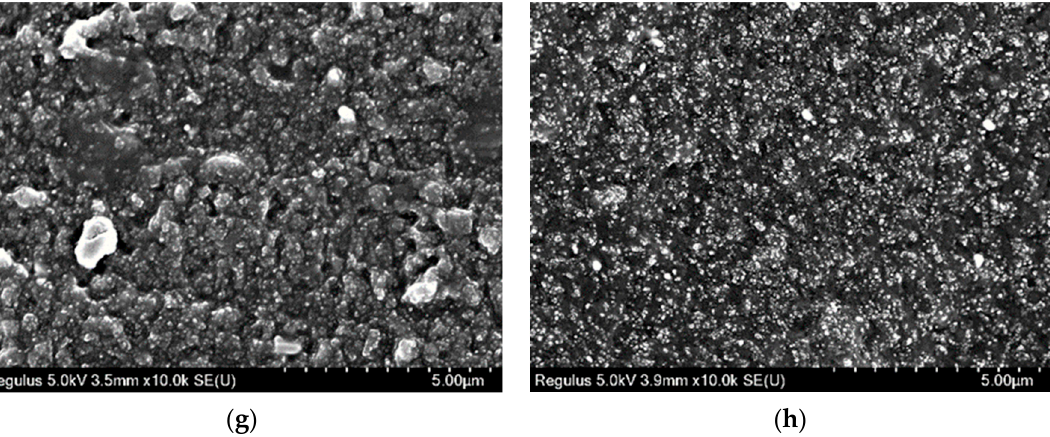
Figure 9. SEM images of SBR section specimen (CB 0-70 phr, magnification 10,000×). ( a ) RG 1–10 phr; ( b ) EG 1–10 phr; ( c ) RG 1–30 phr; ( d ) EG 1–30 phr; ( e ) RG 1–50 phr; ( f ) EG 1–50 phr; ( g ) RG 1–70 phr; ( h ) EG 2–70 phr.